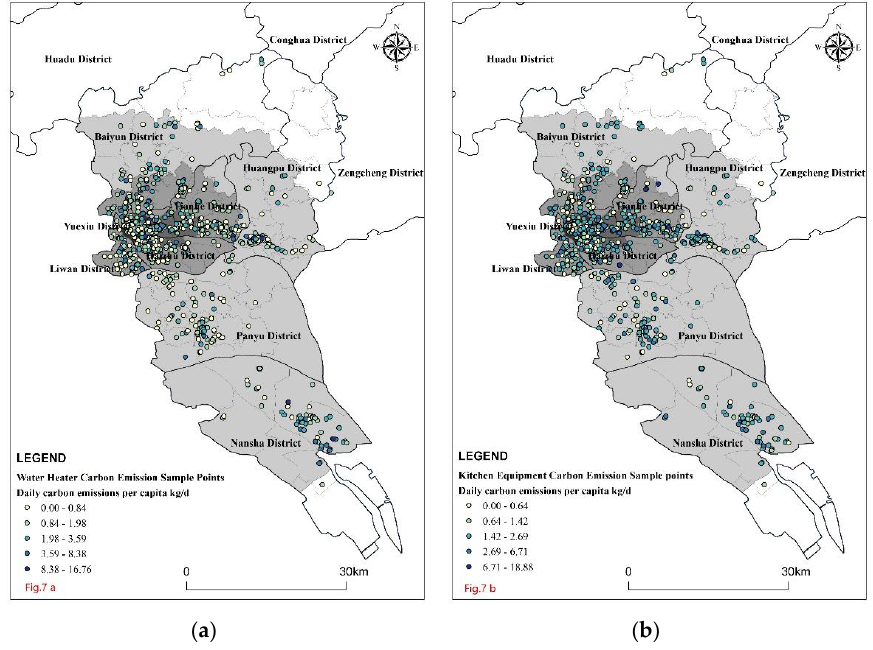
Figure 7. LISA cluster maps of carbon emissions from household equipment in Guangzhou. ( a ) Car- bon emissions from water heaters per capita. ( b ) Carbon emissions from kitchen equipment per capita.